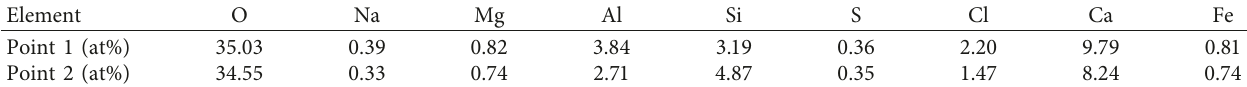
Figure 9: EDS analysis of the new cementitious composite material. (a) Point 1. (b) Point 2. Table 9: EDS analysis result: points 1 and 2.